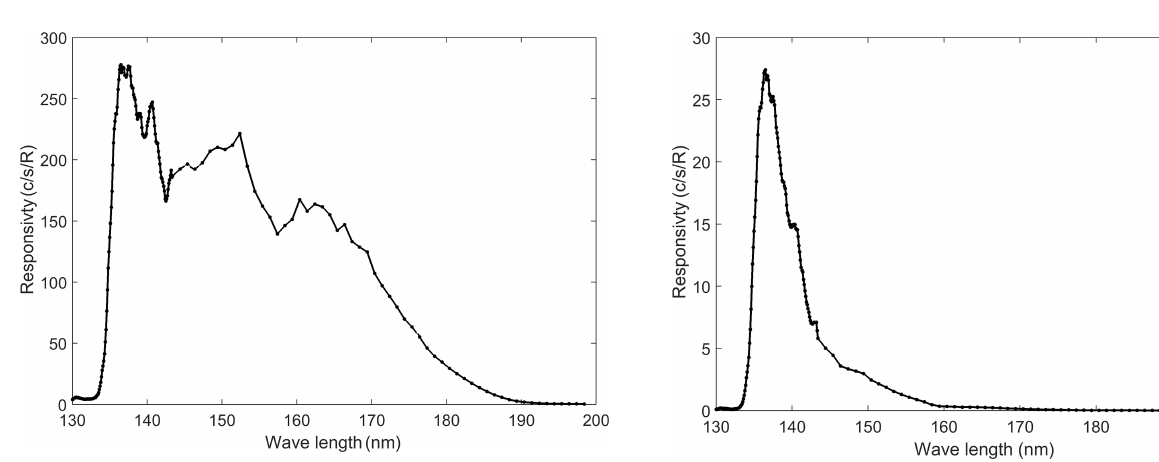
Figure 4. The IPM responsivity of the 135.6nm dayside channel in counts/s/R.